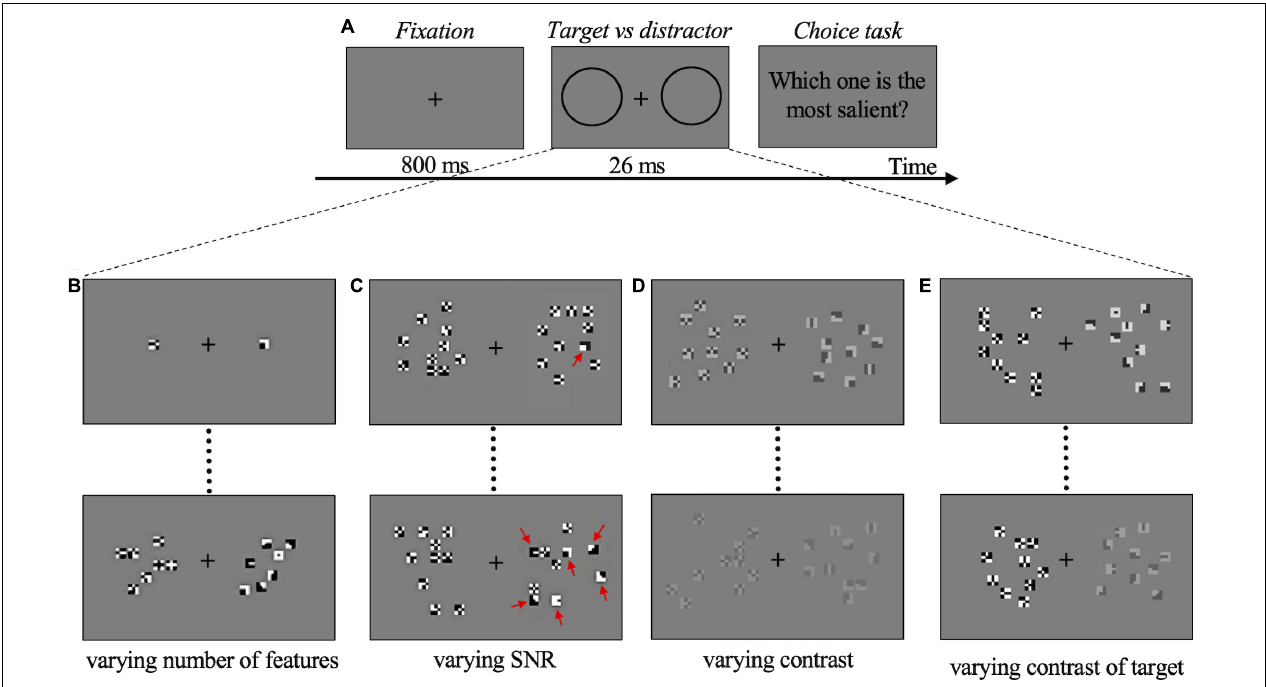
FIGURE 2 | Psychophysics experiments procedure and conditions. (A) Schematic representation of one trial. During stimulus presentation two compounds, target (deemed salient), and distractor (not salient), were presented randomly left/right. The two black circles (not visible in the real display) represent the location of target and distractor, shown below in (B–E) for each experimental condition. In (B–E ), the target is always on the right. (B) Examples of stimuli for Experiment 1. Upper panel: target with 1 optimal feature vs. distractor with 1 non-optimal feature. Lower panel: target with 7 optimal features vs. distractor with 7 non-optimal features. (C) Examples of stimuli for Experiment 2. Upper panel: target with 1 optimal feature plus 9 non-optimal features (SNR = 10%) vs. distractor with 10 non-optimal features. Lower panel: target with 6 optimal features plus 4 non-optimal features (SNR = 60%) vs. distractor with 10 non-optimal features. Red arrows indicate optimal features. (D) Examples of stimuli for Experiment 3. Upper panel: target with 10 optimal features vs. distractor with 10 non-optimal features (contrast of both = 50%). Lower panel: target with 10 optimal features vs. distractor with 10 non-optimal features (contrast of both = 20%). (E) Examples of stimuli for Experiment 4. Upper panel: target with 10 optimal features (contrast = 80%) vs. distractor with 10 non-optimal features (contrast = 100%). Lower panel: target with 10 optimal features (contrast = 65%) vs. distractor with 10 non-optimal features (contrast = 100%). Compounds and features are oversized for illustration purposes. The target-distractor compounds position in the trials is